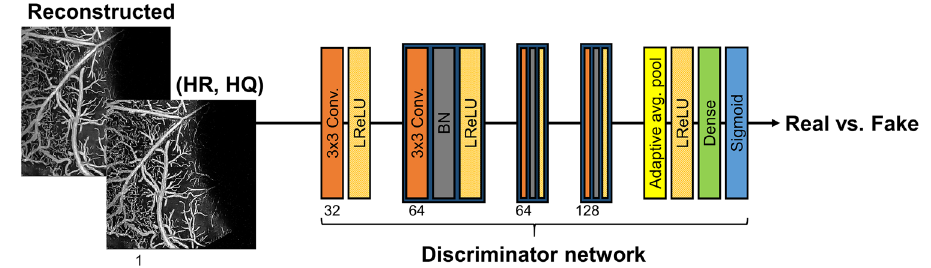
Figure 4. Architectural description of the discriminator network used for the adversarial training. (HR, HQ), high-resolution and high-quality; LReLU, leaky rectified linear unit; and BN, batch